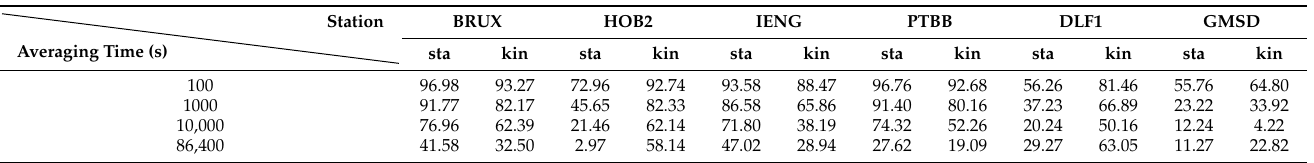
Table 4. Improvement percentage of stability of the GPS receiver clock offset with and without the clock modelling (static: sta; kinematic: kin).